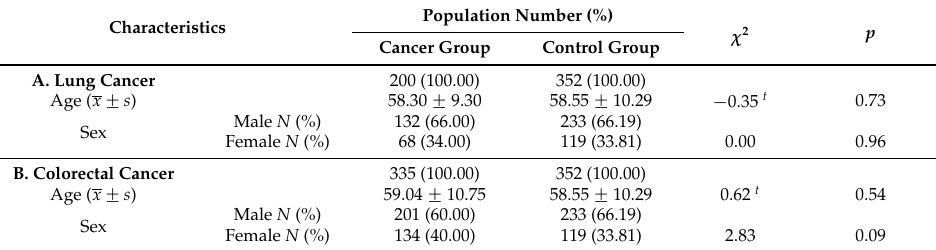
Table 1. Age and sex distribution in tested